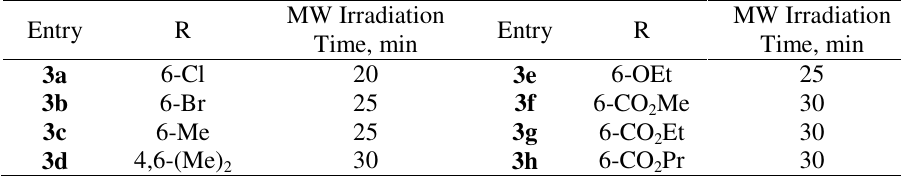
Table 2. Reaction Time for synthesis of thioureas